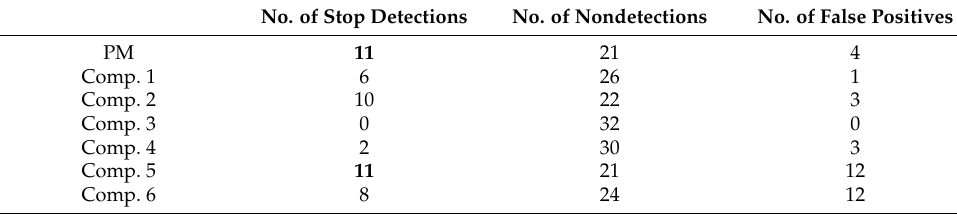
Figure 9. Comparative example of visualization timing of stops. Table 7. Quantitative evaluation of visualization